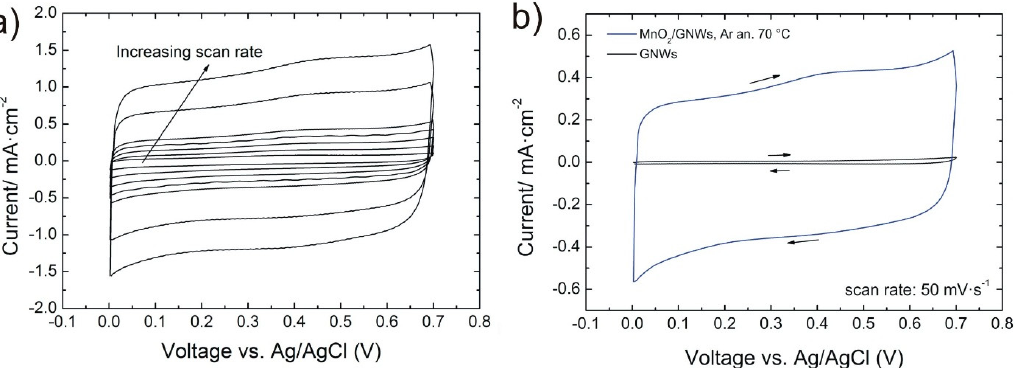
Figure 4. ( a ) Cyclic voltammograms of MnO 2 /GNWs sample annealed at 70 ◦ C using scan rates 10, 20, 30, 40, 50, 100, and 150 mV · s − 1 . ( b ) Bare GNWs and MnO 2 /GNWs sample annealed at 70 ◦ C using a scan rate of 50 mV · s − 1 and a voltage window between 0.0 to 0.7 V vs. Ag/AgCl. Arrows indicate the direction of the scan.